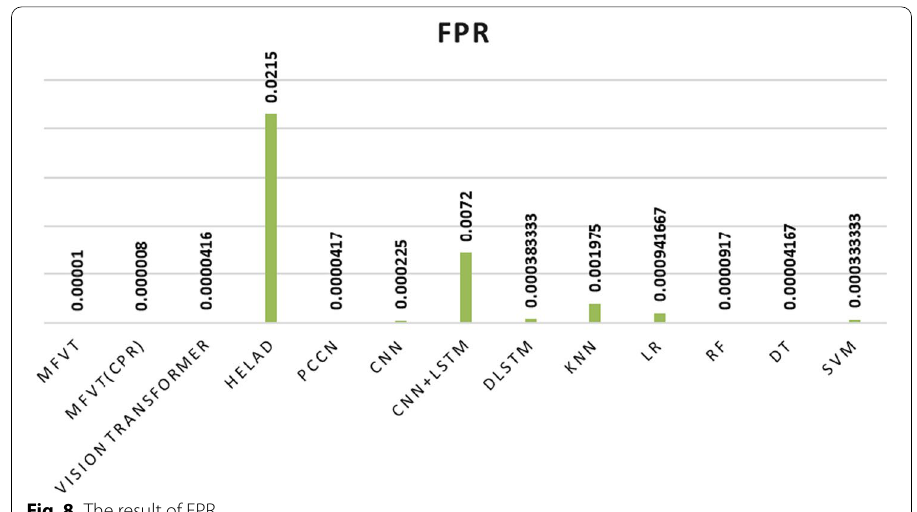
Fig. 8 The result of FPR